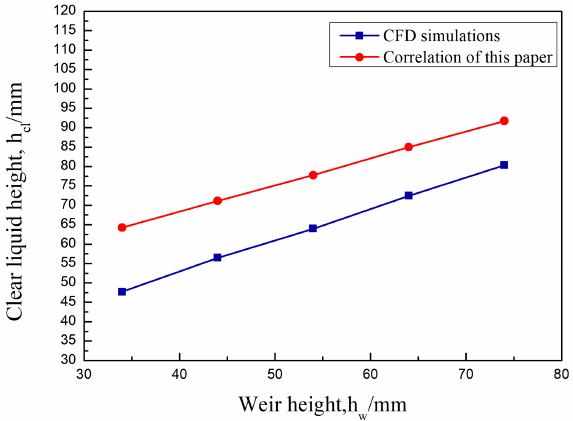
Figure 7. Clear liquid height as a function of the weir height. U S = 0.65 m/s, Q L /L w = 20 m 3 /(m·h).